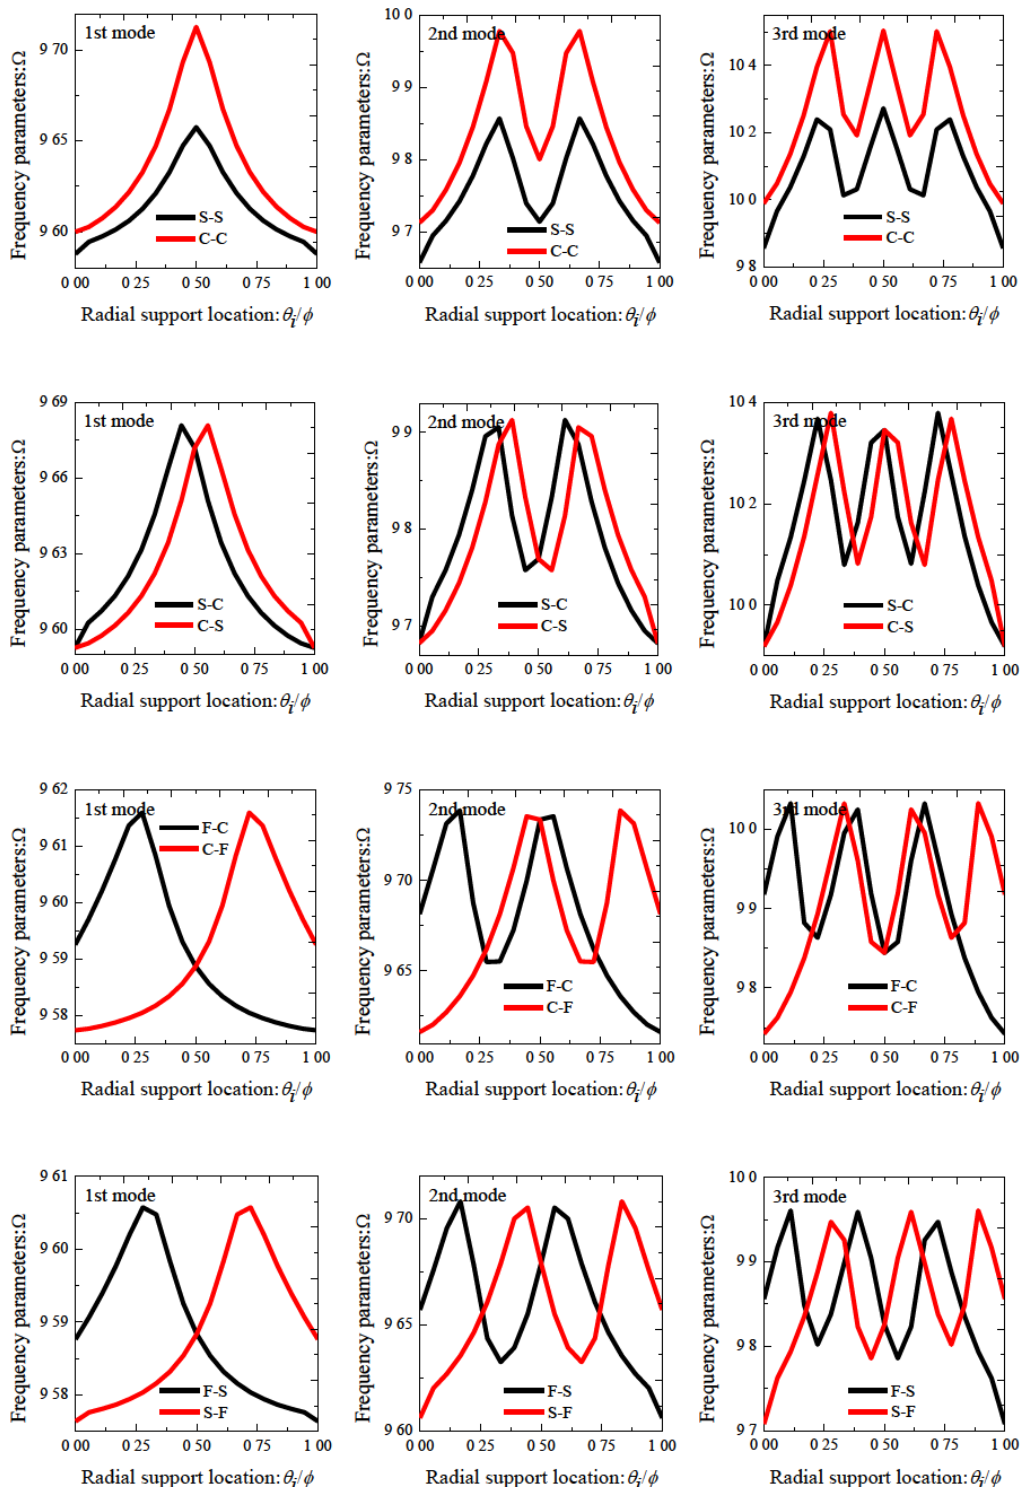
Figure 12: Variation of the frequency parameters Ω versus the radial support locations for a [0 ∘ /90 ∘ /90 ∘ /0 ∘ ] laminated annular sector plate with a θ direction internal radial support ( E 1 / E 2 =15, a / b =0.5, h / b =0.1, ϕ = π